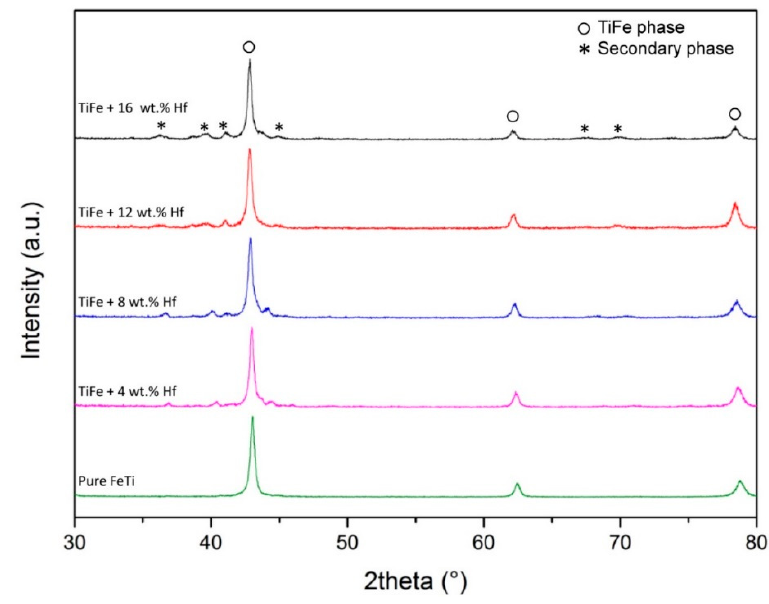
Figure 1. XRD (X Ray Diffraction) patterns of pure as-cast TiFe and TiFe + x Hf alloys. x = 4, 8, 12, and 16 wt.%. Table 1. Cell parameters and crystallites size of TiFe + x wt.% Hf (x = 0, 4, 8, 12, and 16). The uncertainty on the lattice parameters and crystallite sizes were identical for all composition and respectively 0.002 Å and 1